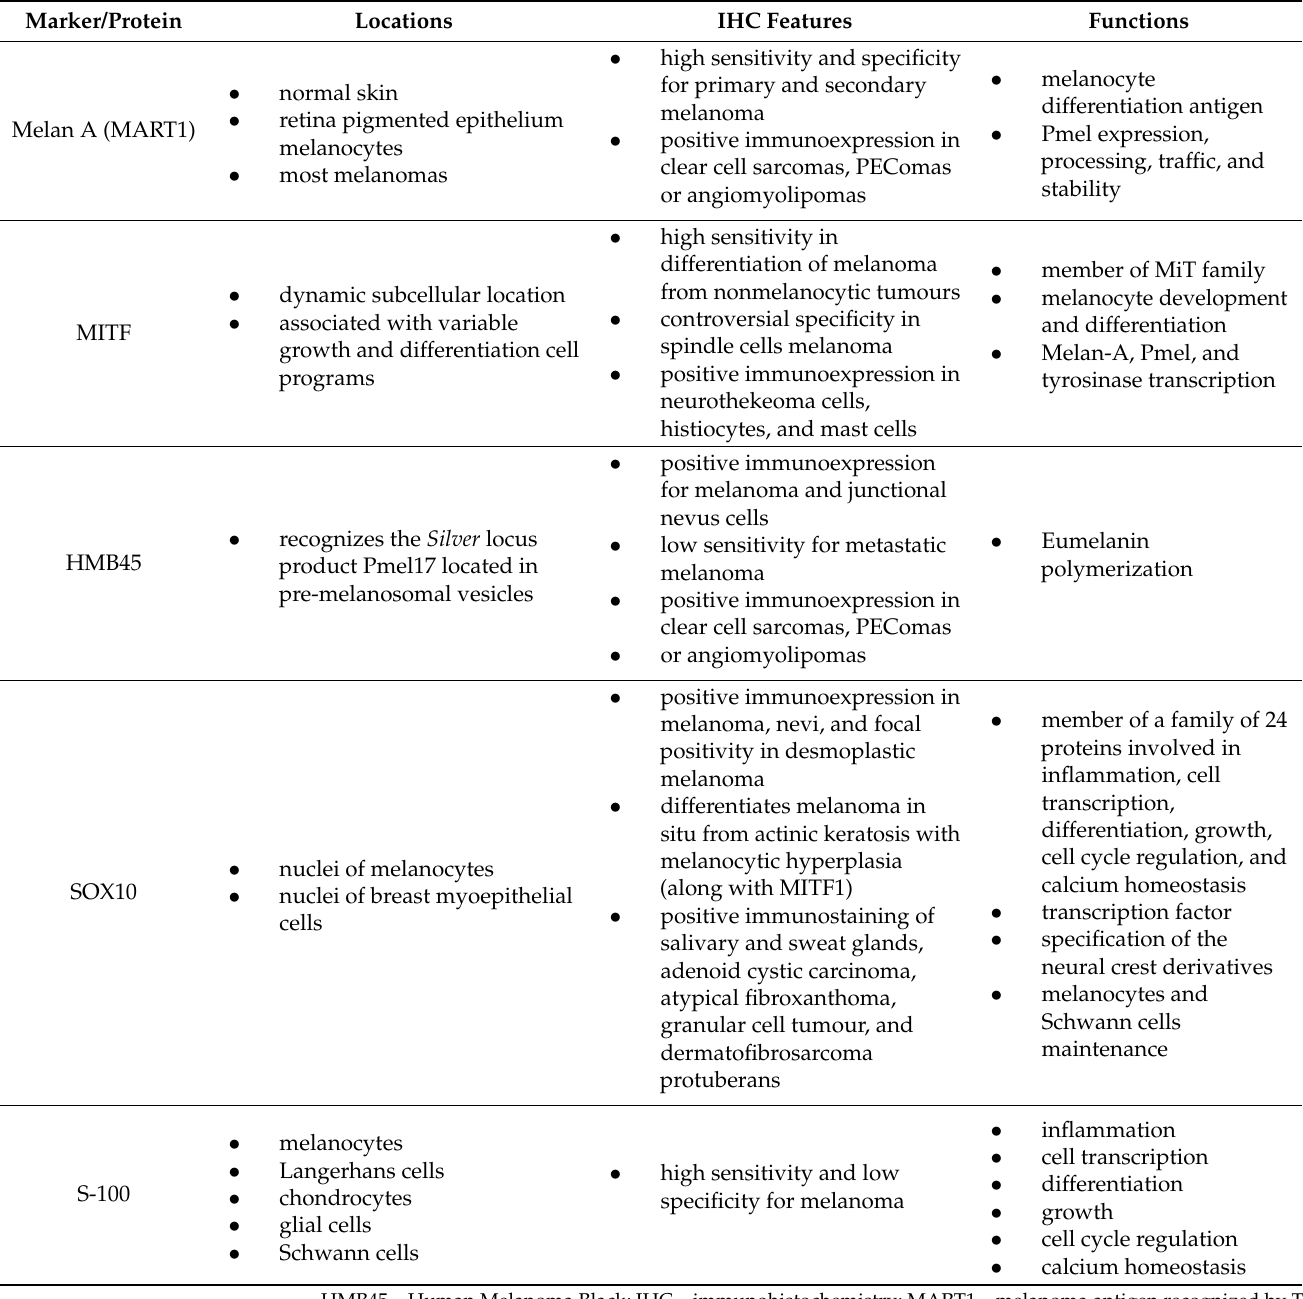
Table 2. Immunohistochemical markers useful in malignant melanoma